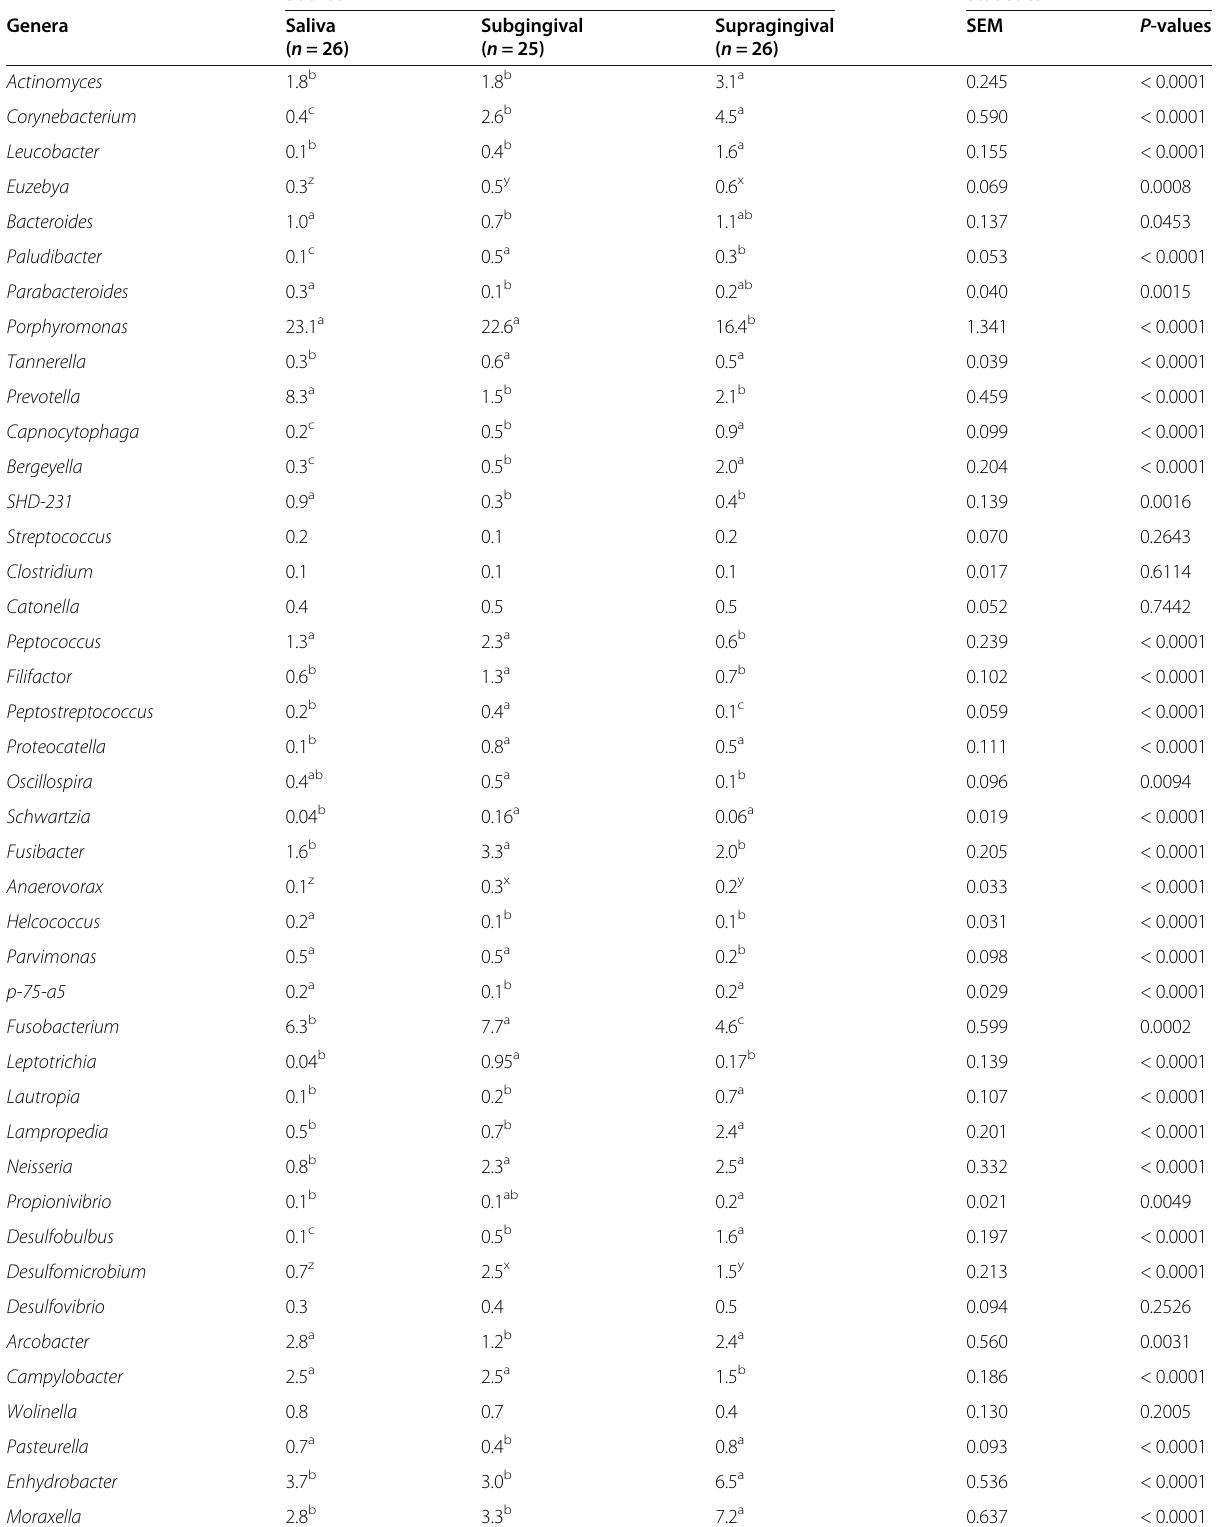
Table 3 Oral bacterial genera (relative abundance, %) present in plaque (supragingival and subgingival plaque) and saliva samples from healthy adult